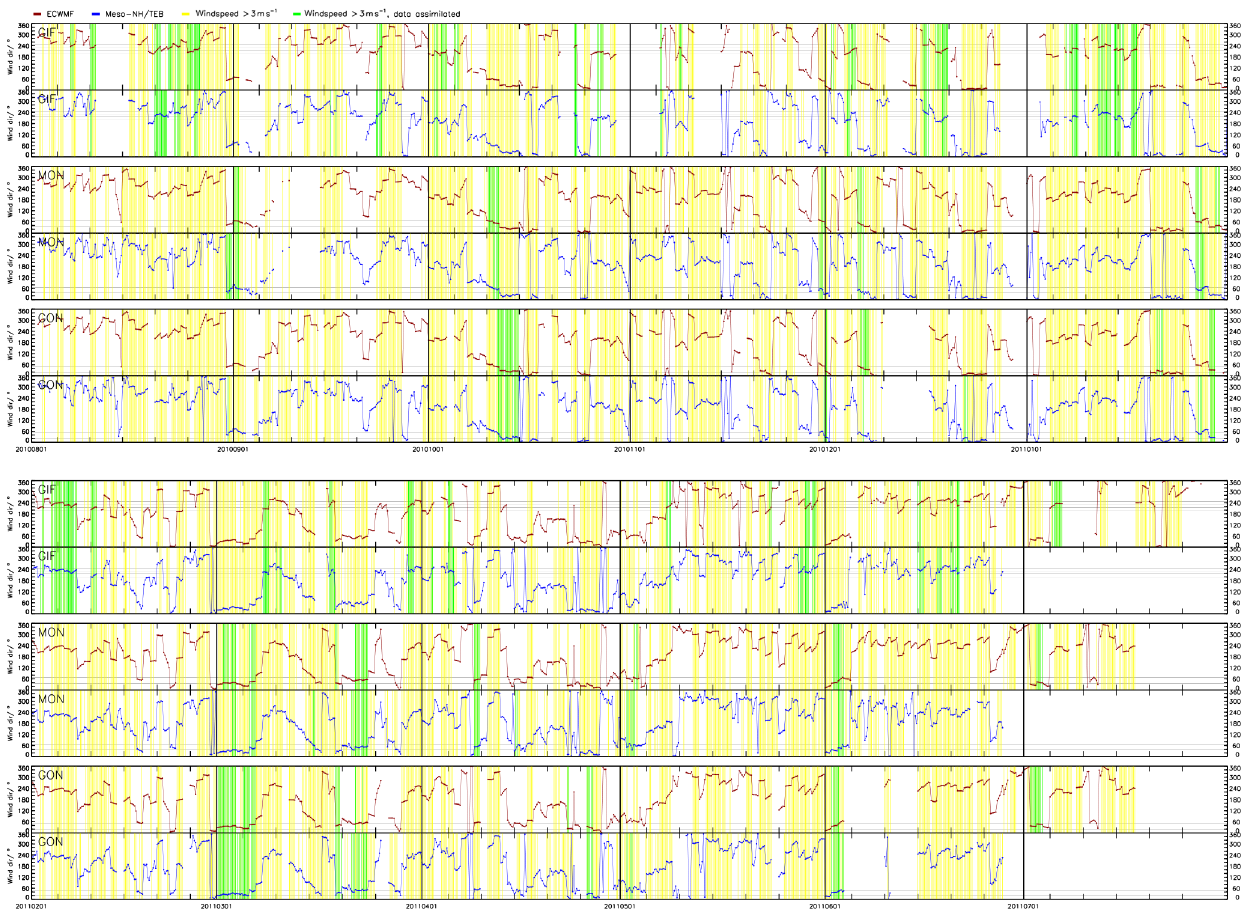
Figure A1. Time series of mean wind directions during the afternoon (12:00–16:00) at the different monitoring sites used in this study. Solid horizontal lines: the range of wind directions used by the reference (stringent) gradient selection (see Sect. 2.2). Red: wind directions as simulated by ECMWF. Blue: wind directions as simulated by Meso-NH/TEB. Yellow vertical lines: wind speed > 3ms − 1 . Green vertical lines: data are actually assimilated when using the reference (stringent) gradient selection